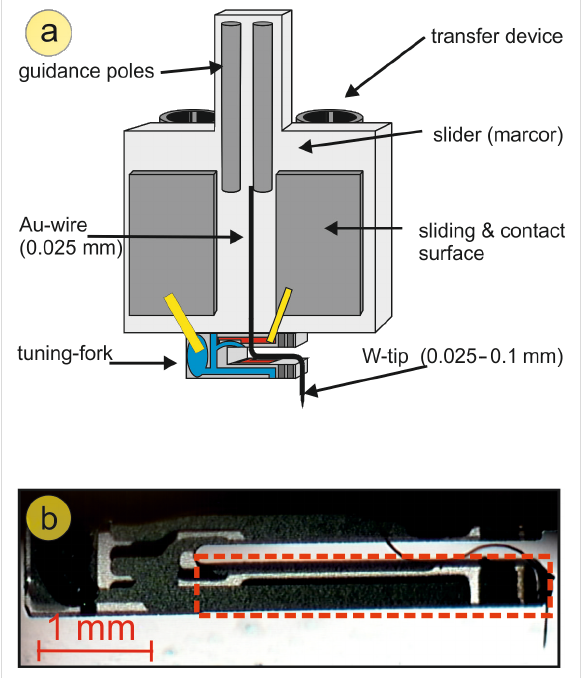
Figure 3: (a) Sketch of the qPlus configuration in our setup. (b) Picture of a mounted tuning fork. The area marked in red indicates the part of the tuning fork that is used to estimate the spring constant based on the formula for a rectangular